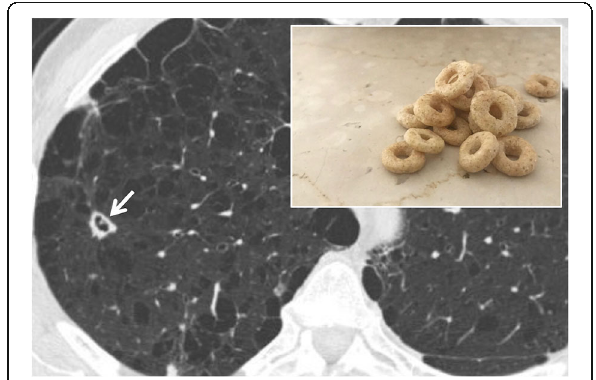
Fig. 5 Cheerios sign. The cheerios sign is due to cell proliferation around a bronchial branch (white arrow); it may be found in patients with Langerhans Cell histiocytosis or lung adenocarcinoma. It is very similar to the appearance of the famous breakfast cereal — as well demonstrated in the embedded